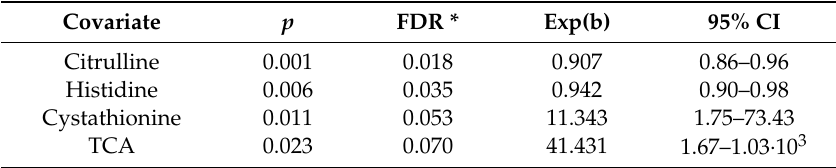
Table 2. Univariate Cox regression analysis of the baseline